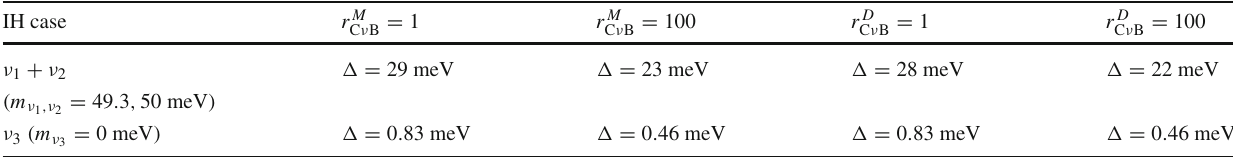
Table 5 The required (cid:9) to distinguish the C ν B signal and the β -decay background for the several ν i with the mass m ν Majorana cases in the inverted mass ordering. Here we also neglect δ f d ν